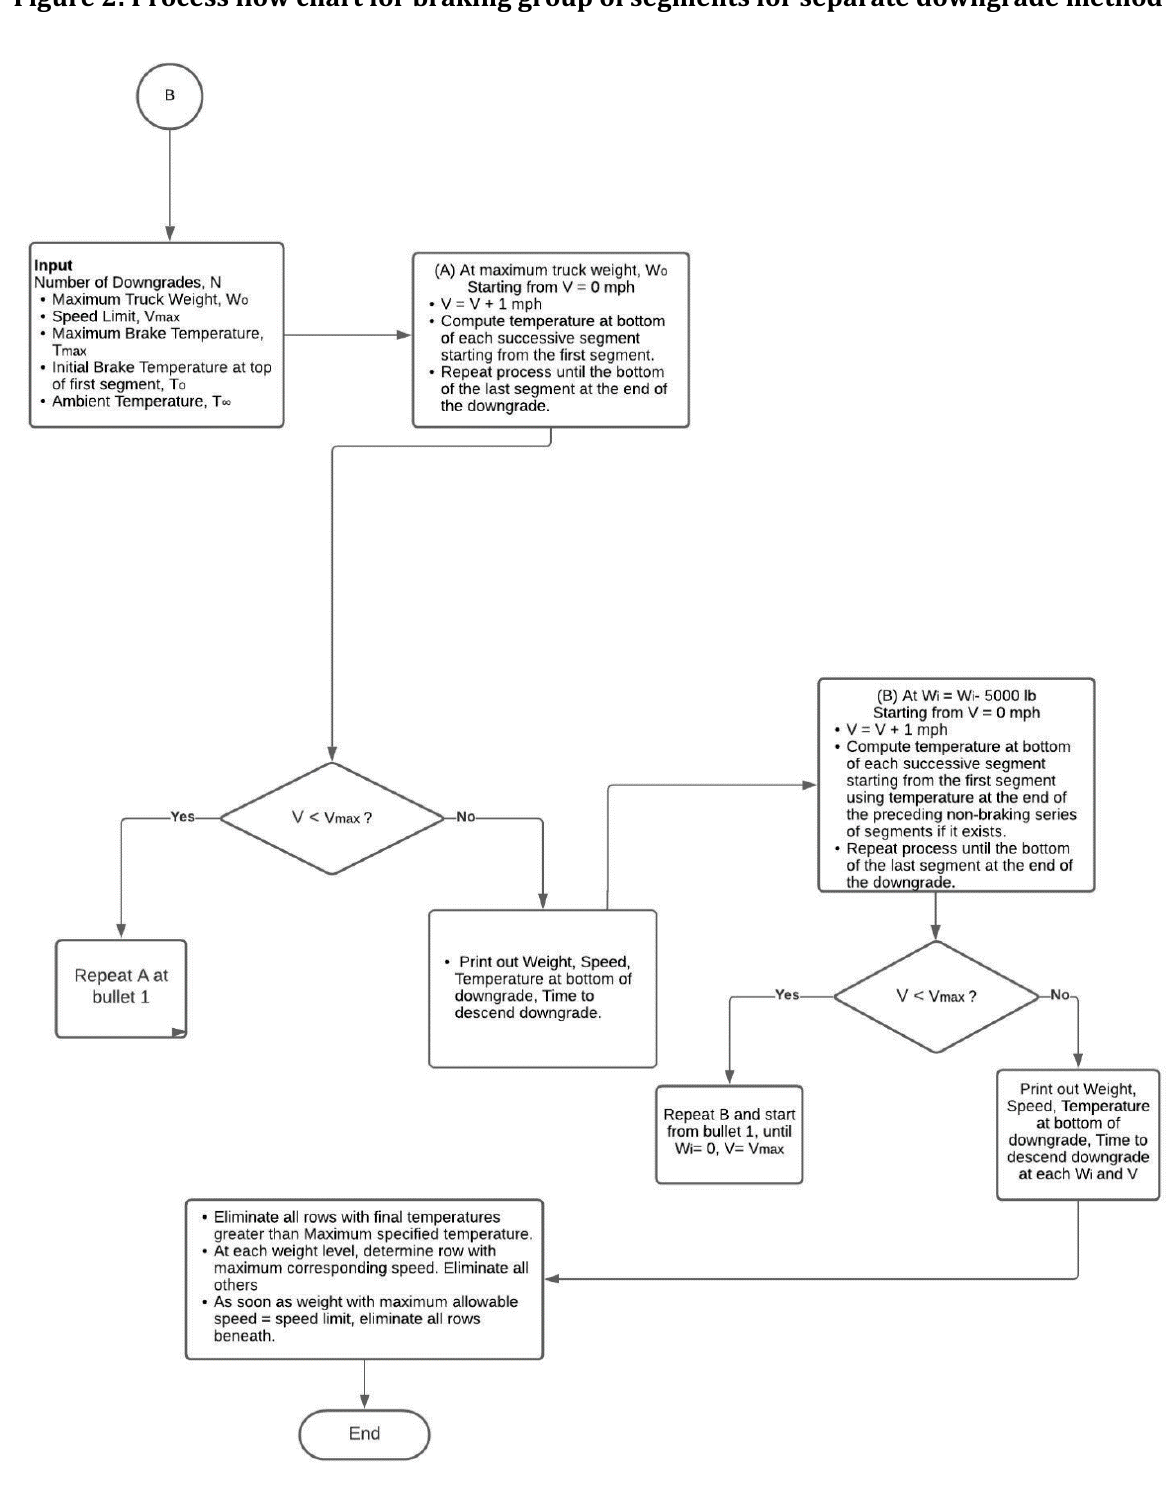
Figure 2: Process flow chart for braking group of segments for separate downgrade